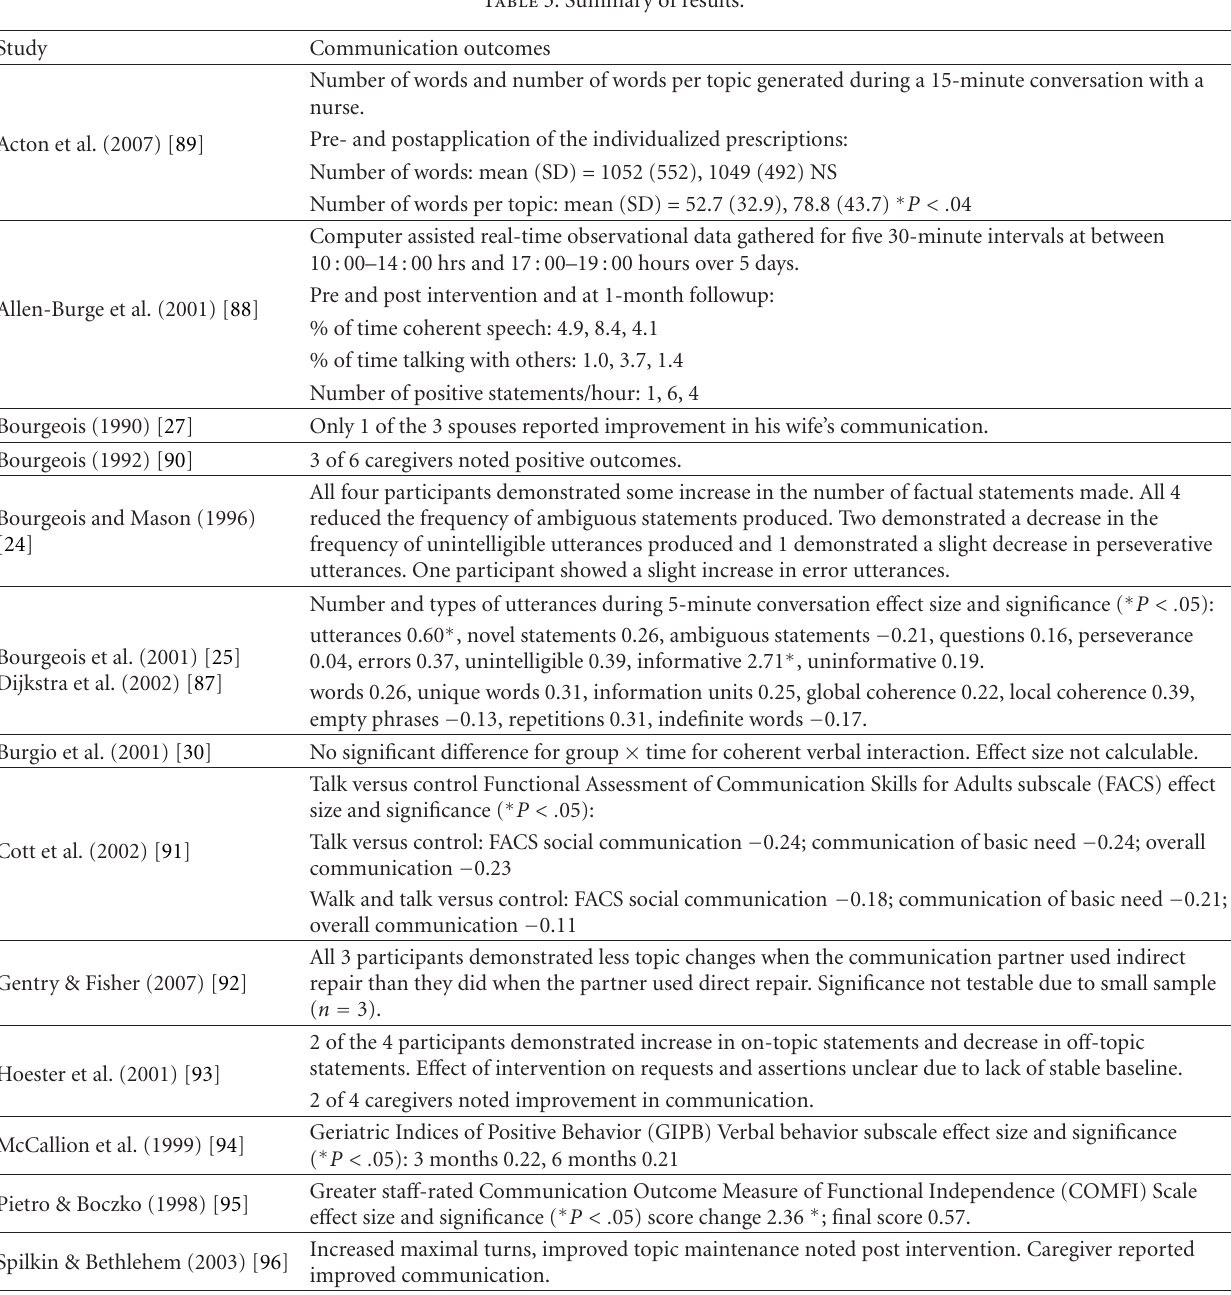
Table 3: Summary of